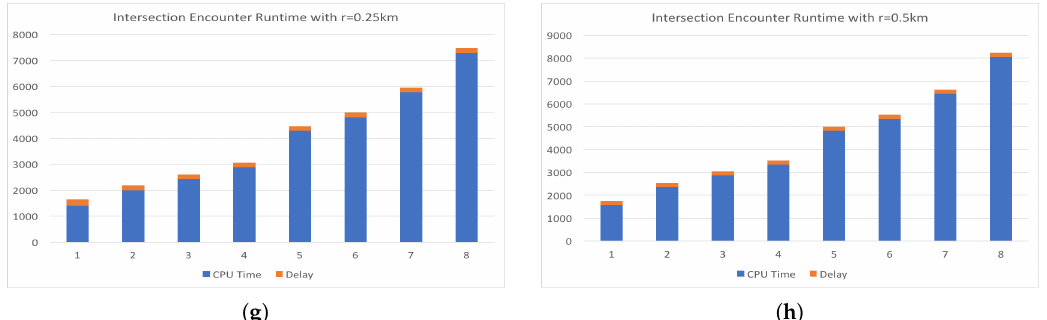
Figure 8. Comparison of CPU time and round trip communication delay for geographically dispersed resources. The sum of the bar segments is equal to the total time for the request to be sent, processed, and results returned. Figures ( a ) and ( b ) illustrate the run time and delay for requests sent to the “east” server, ( c ) and ( d ) the “central”, ( e ) and ( f ) the “west”, and finally ( g ) and ( h ) the “cin”